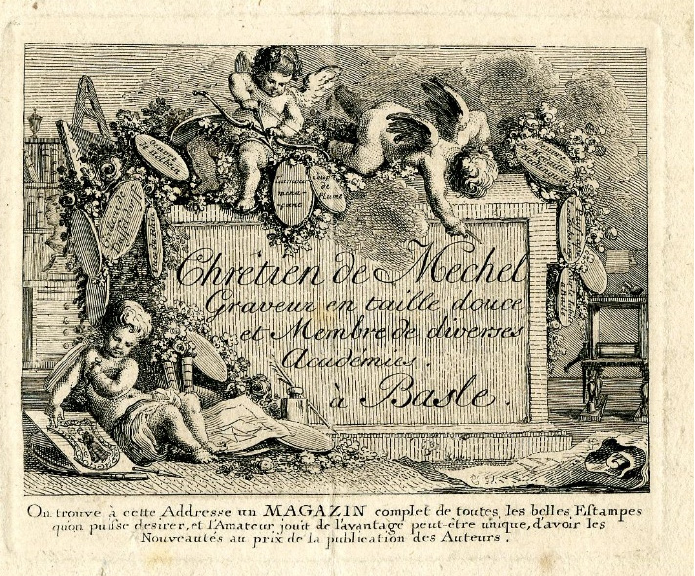
Figure 7. Balthasar Anton Dunker (Germany 1746–1807), Trade card of Chrêtien de Mechel , 1789, Etch- ing and engraving, 73 cm × 89 cm, The British Museum, London.